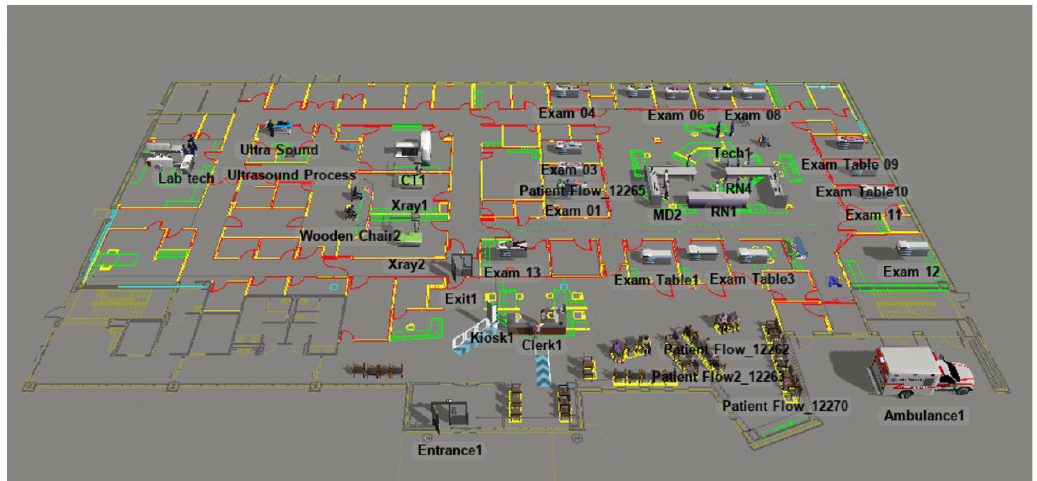
Figure 2 . The 3D perspective image of the simulation modeling connects space resources with staff resources and patient flow (Image Copyright: